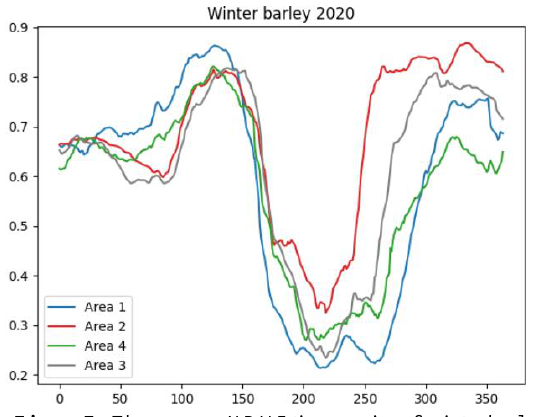
Figure 7. The average NDVI times series of winter barley for our 4 areas.